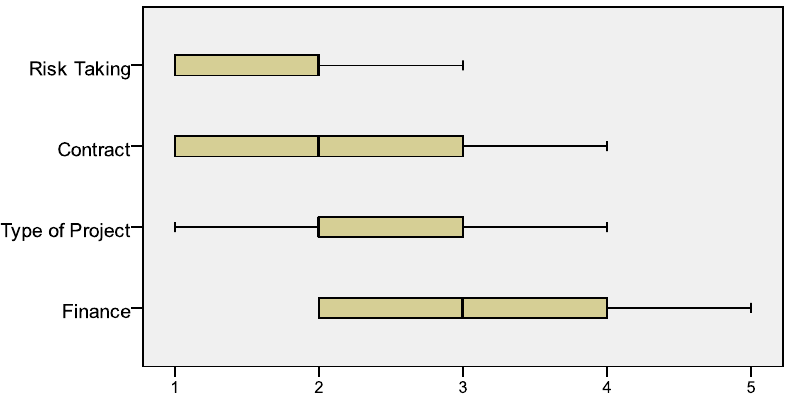
Figure 3. Factors influencing a company’s project decision making in estimating stage.